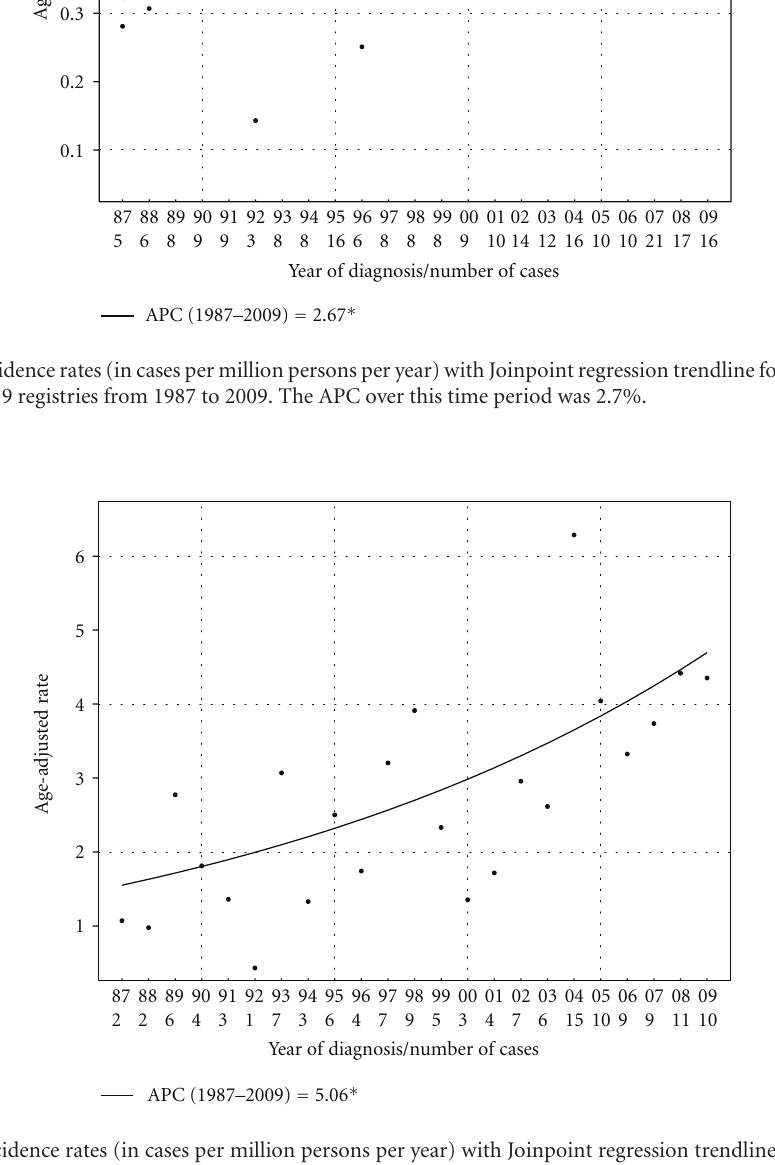
Figure 3: Age-adjusted incidence rates (in cases per million persons per year) with Joinpoint regression trendline for white female patients ages 55 to 84 with MMHN in SEER 9 registries from 1987 to 2009. The APC over this time period was